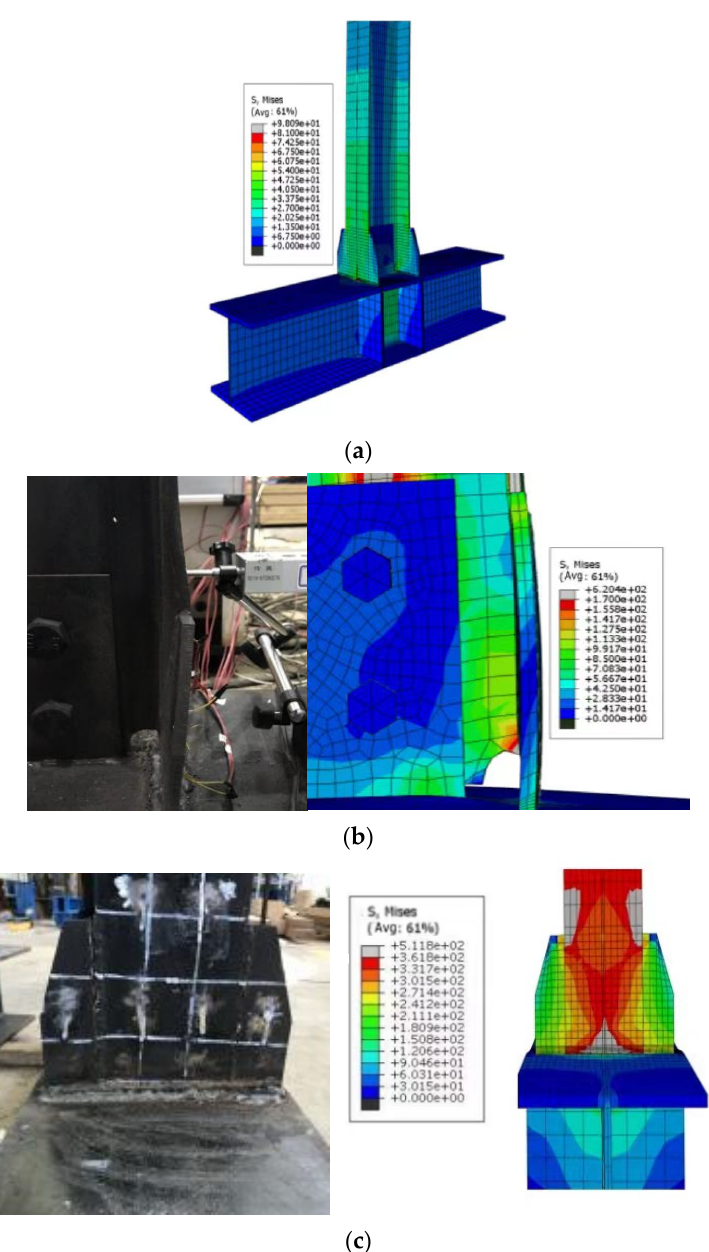
Figure 13. Comparison of deformation of SRN specimen: ( a ) elastic phase; ( b ) plastic hinge position comparison; ( c ) comparison of flange damage.